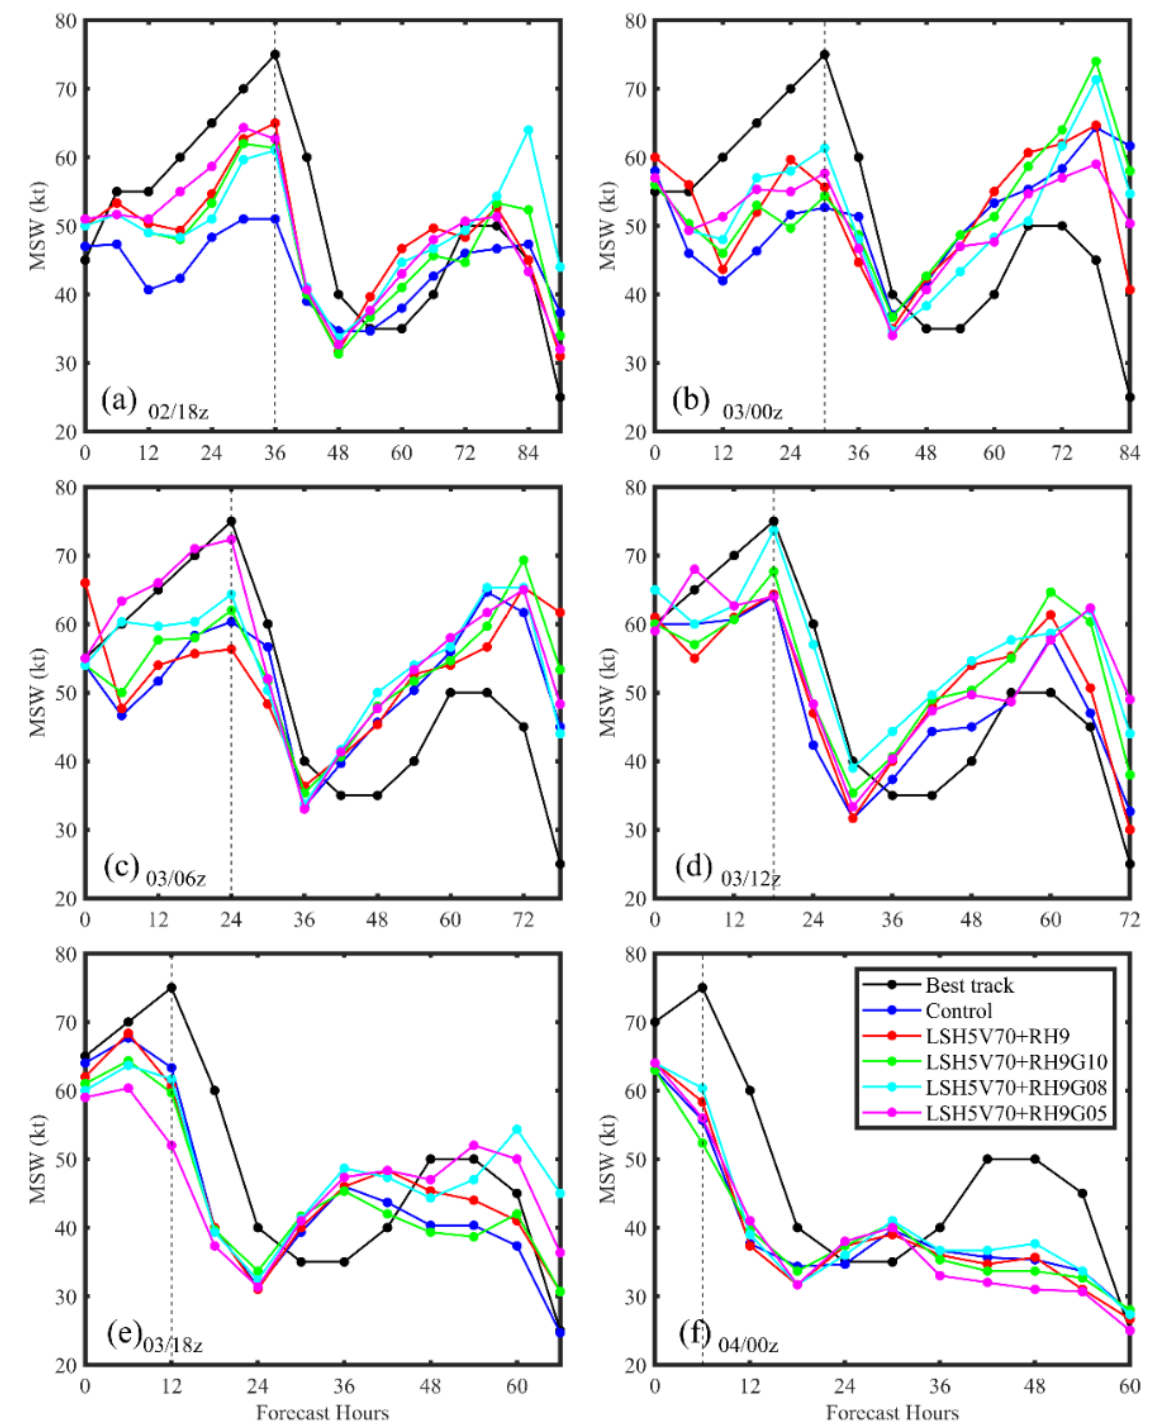
Figure 14. Comparison of the forecast MSW for Hurricane Earl from Control, LSH5V70 + RH9, LSH5V70 + RH9G10, LSH5V70 + RH9G08, and LSH5V70 + RH9G05 at ( a ) 18 UTC 2, ( b ) 00 UTC 3, ( c ) 06 UTC 3, ( d ) 12 UTC 3, ( e ) 18 UTC 3, and ( f ) 00 UTC 4 August 2016.